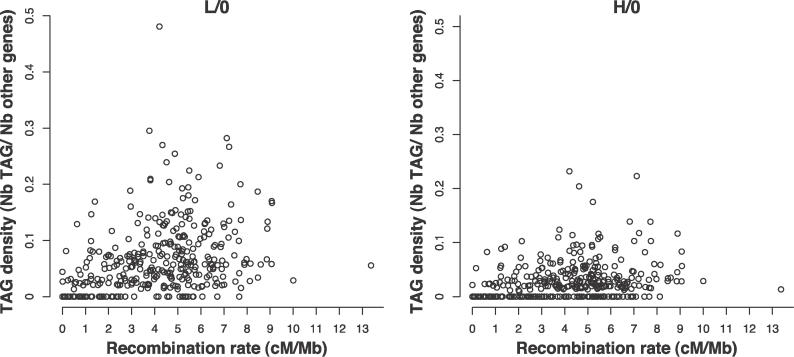
TAG Gene Density Plotted against Recombination Rate in O. sativa for the L/0 Dataset and the H/0 Dataset